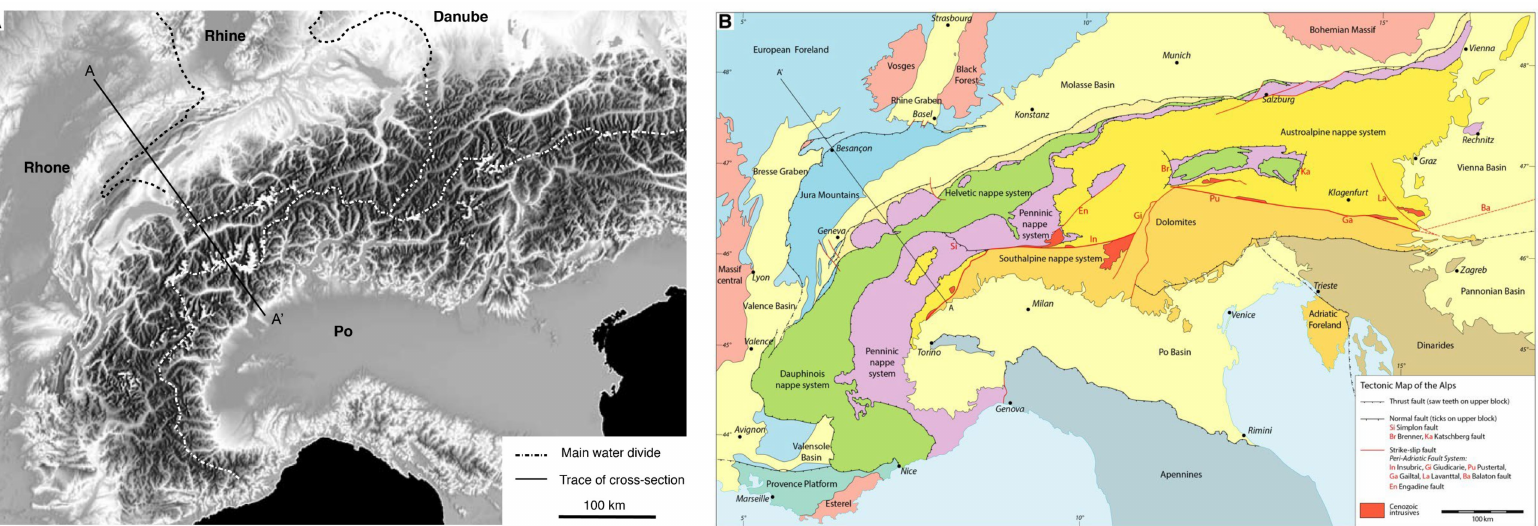
Figure 2. Regional maps of the Alps with cross section line A-A’ shown in Figure 3. ( A ) Digital elevation model with the main drainage divides delimiting the hydrographic basins of the Rhine, Po and Danube rivers. ( B ) Tectonic map of the Alps and their foreland showing the main nappe systems and foreland basins.